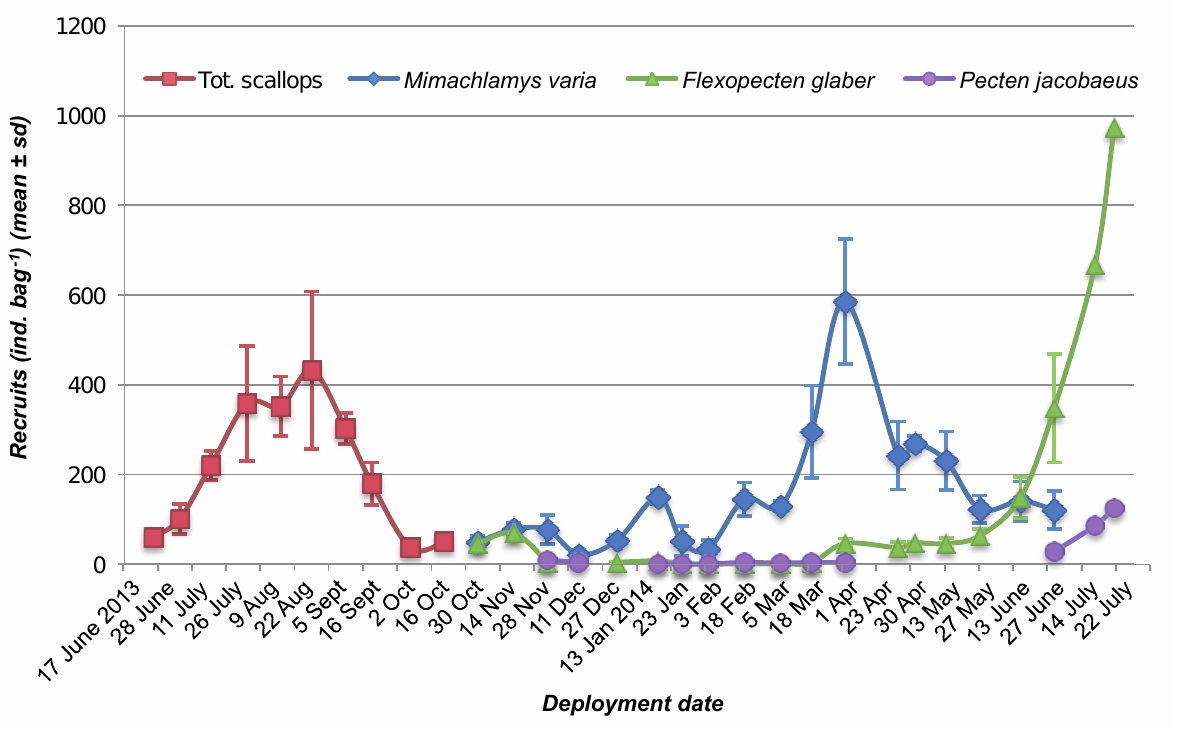
Figure 4. Species occurrence of the three identified scallop species found on collectors within the period from October 2013 to July 2014.